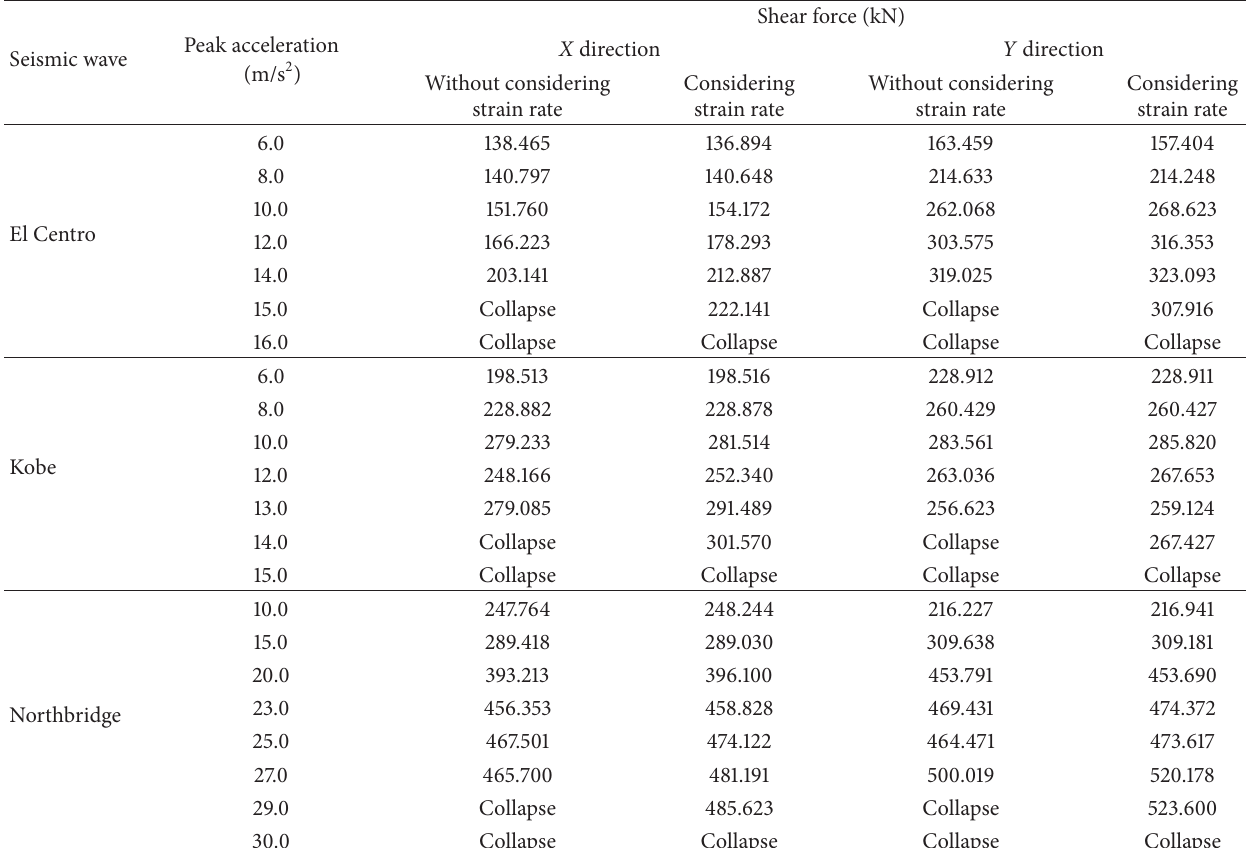
Table 4: Maximum base shear forces of 2nd transmission